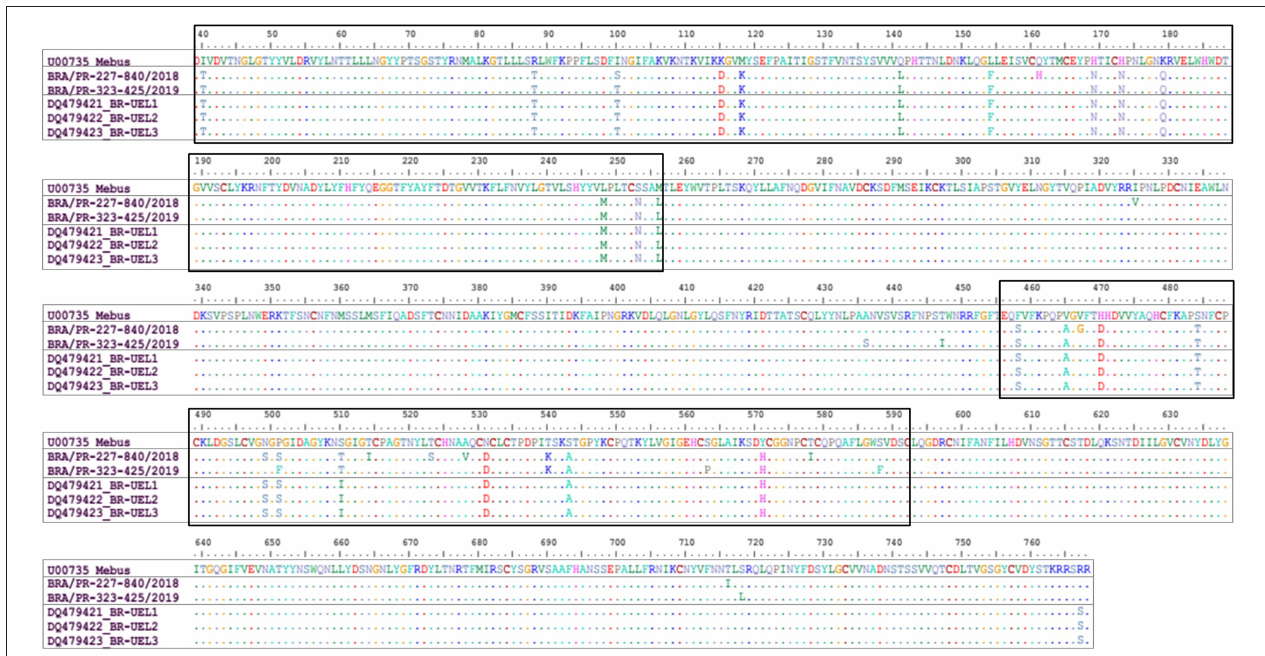
FIGURE 2 | Alignment of the deduced amino acid (39-768 aa concerning the Mebus prototype strain) sequences of the S gene of bovine coronavirus strains. Rectangles show the amino acid changes in two domains observed in the Brazilian strains in this study. The first domain comprises the region of 40-256 deduced amino acid residues. The second domain comprises the hypervariable region between 456-592 deduced amino acid residues.